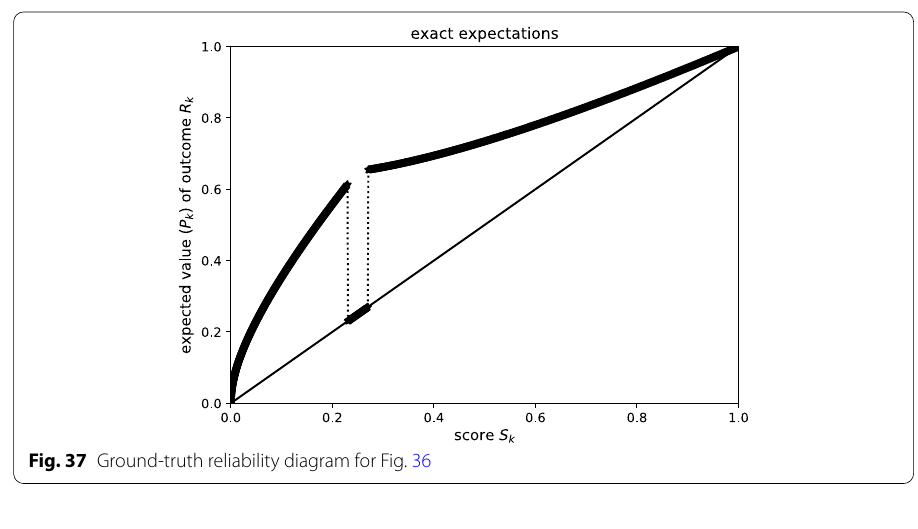
Fig. 37 Ground-truth reliability diagram for Fig.